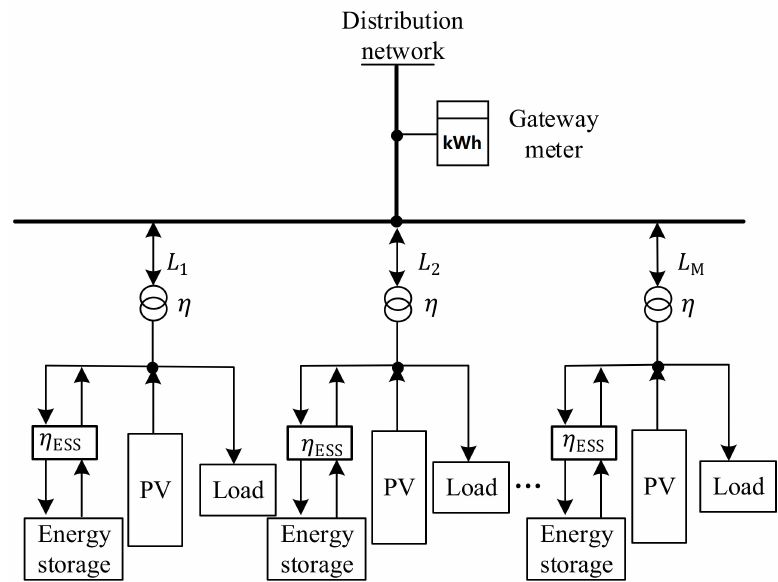
Figure 1. Structure of user-side multi-transformer-integrated